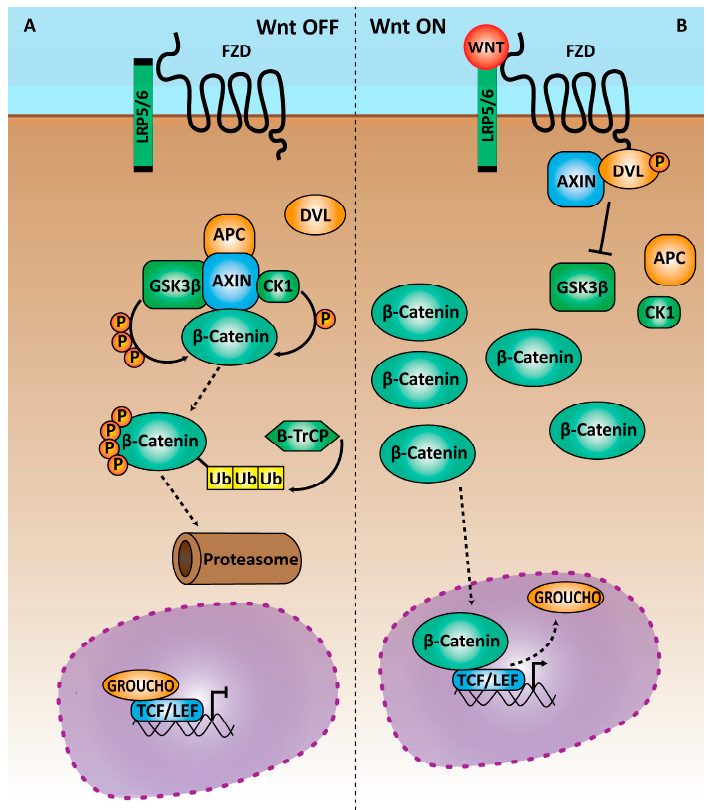
Figure 1. Molecular overview of the Wnt/ β -catenin pathway. ( A ) In absence of Wnt ligands (Wnt OFF conditions), the β -catenin destruction complex phosphorylates β -catenin, which is ubiquitinated by β -TrCP and sent to the proteasome, where it is degraded. Thus, absence of nuclear β -catenin enables repression of Wnt target genes through the T-cell factor (TCF)/lymphoid enhancer factor (LEF) transcription factors. ( B ) When Wnt ligands bind to the receptor complex, the destruction complex is disassembled allowing the stabilization of β -catenin, which is then able to translocate to the nucleus. Nuclear β -catenin is then able to elicit gene expression changes through the TCF/LEF family of transcription factors. APC: adenomatous polyposis coli; CK1: casein kinase 1; DVL: dishevelled; FZD: frizzled; GSK3 β : glycogen synthase kinase 3 beta; LRP5/6: lipoprotein receptor-related protein 5/6; Ub: ubiquitin.